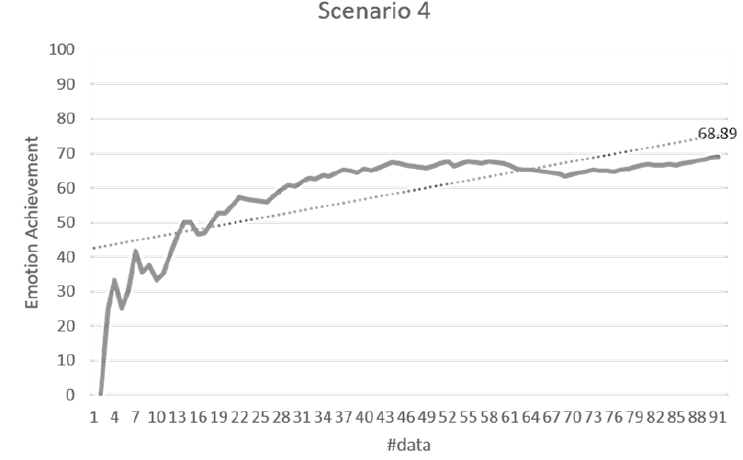
Figure 18. Emotion achievement for scenario 4. The thick line shows the increase of the achievement according to the number of sensory changes, and the dotted line shows the trend of this increase.